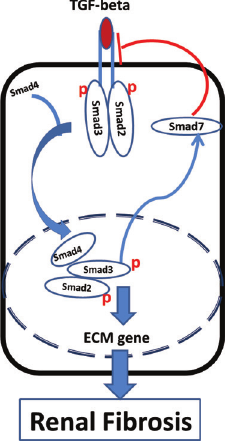
Figure 1. Various roles of Smads in renal fibrosis. P represents phosphorylated Smad. The phosphorylated Smad2 and Smad3 bind to Smad4 and form the Smad complex, which translocates into the nucleus and regulates the target gene transcription, including Smad7. Blue lines indicate pathogenic regulation pathways, while red arrows represent protective regulation pathways. Smad2 and Smad3 act as TGF-β/activin signaling and Smad 4 acts as transport of Smad2 and Smad3. Smad7 is an inhibitory Smad that functions to block Smad2/3